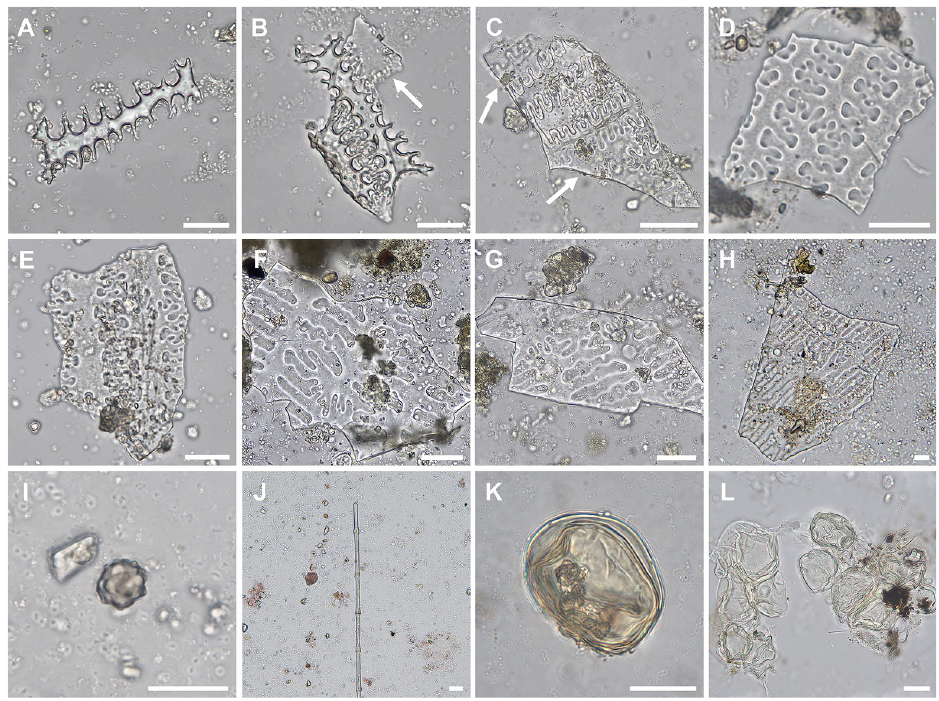
Fig 7. Key microparticle types recovered from dental calculus of KDK1 Middle Neolithic period individuals. (A) E LONGATE DENDRITIC phytolith, individual SK 134; (B–C) E LONGATE DENDRITIC phytoliths overlaying I NTERDIGITATE phytoliths, individuals SK 55 (B) and SK 97 (C); (D) I NTERDIGITATE phytoliths ( cf . Panicum spp.), individual SK 55; (E) I NTERDIGITATE phytoliths ( cf . Panicum spp.), individual SK 62; (F–H) I NTERDIGITATE phytoliths ( Echinochloa spp.), individual SK 97; (I) S PHEROID ECHINATE phytolith, individual SK 134; (J) Feather barbule fragment, individual SK 84; (K–L) Fungal spores, individuals SK 134 (K) and SK 42 (L). White arrows in Panel B and C indicate I NTERDIGITATE phytolith layer attached to E LONGATE DENDRITIC phytoliths. Scale bar (20 μ m) applies to all panels. https://doi.org/10.1371/journal.pone.0280347.g007 between groups ( p = 0.001, refer to S7 Table in S1 File). This result is expected due to the co- occurrence of morphotypes within individual plants (multiplicity) and between species